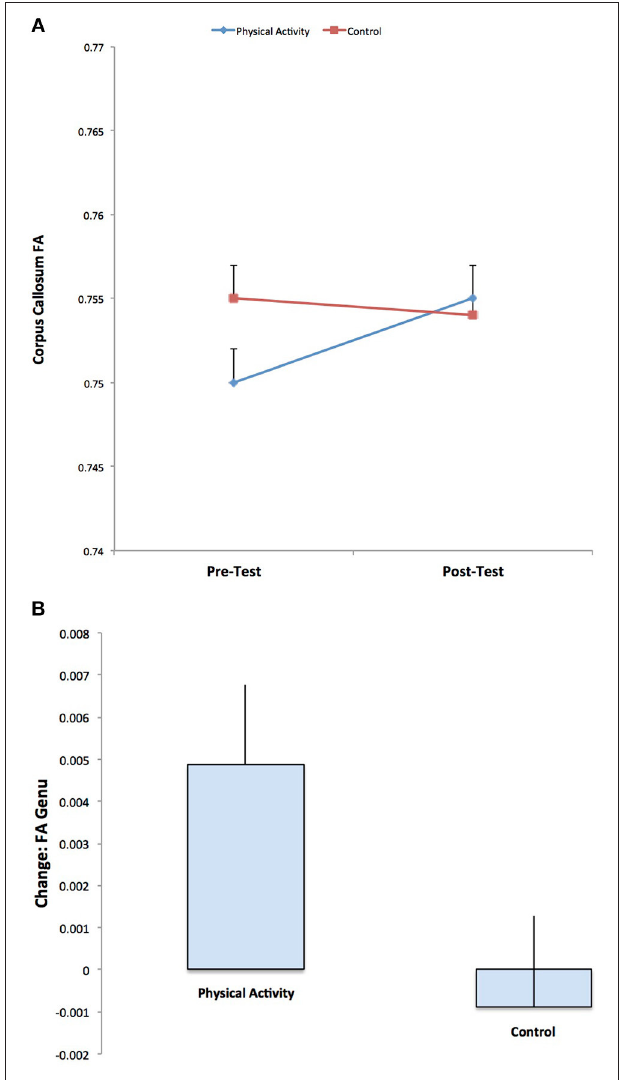
FIGURE 2 | Illustration of the significant Group × Time interaction for FA in the genu of the corpus callosum, with the physical activity group showing significant increases in FA from pre-test to post-test, and no changes in FA for the control group. The result suggests increased estimates of white matter microstructure and fiber integrity with physical activity participation.